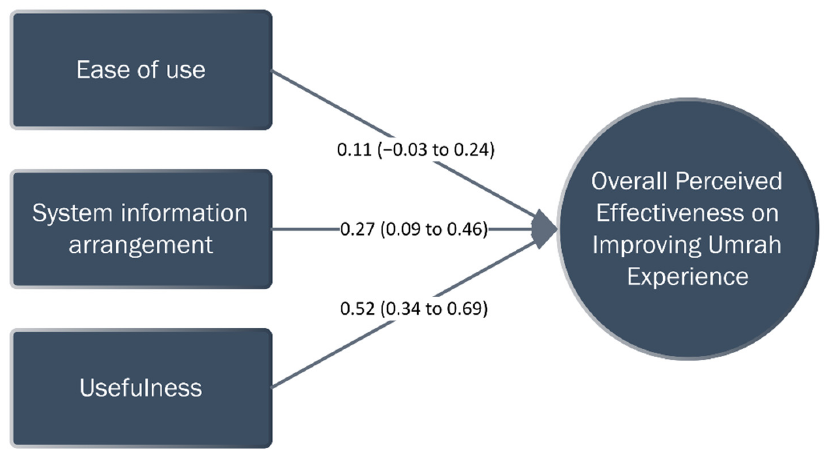
Figure 4. The impact of Eatmarna application usability on the overall effectiveness on improving Umrah experience.